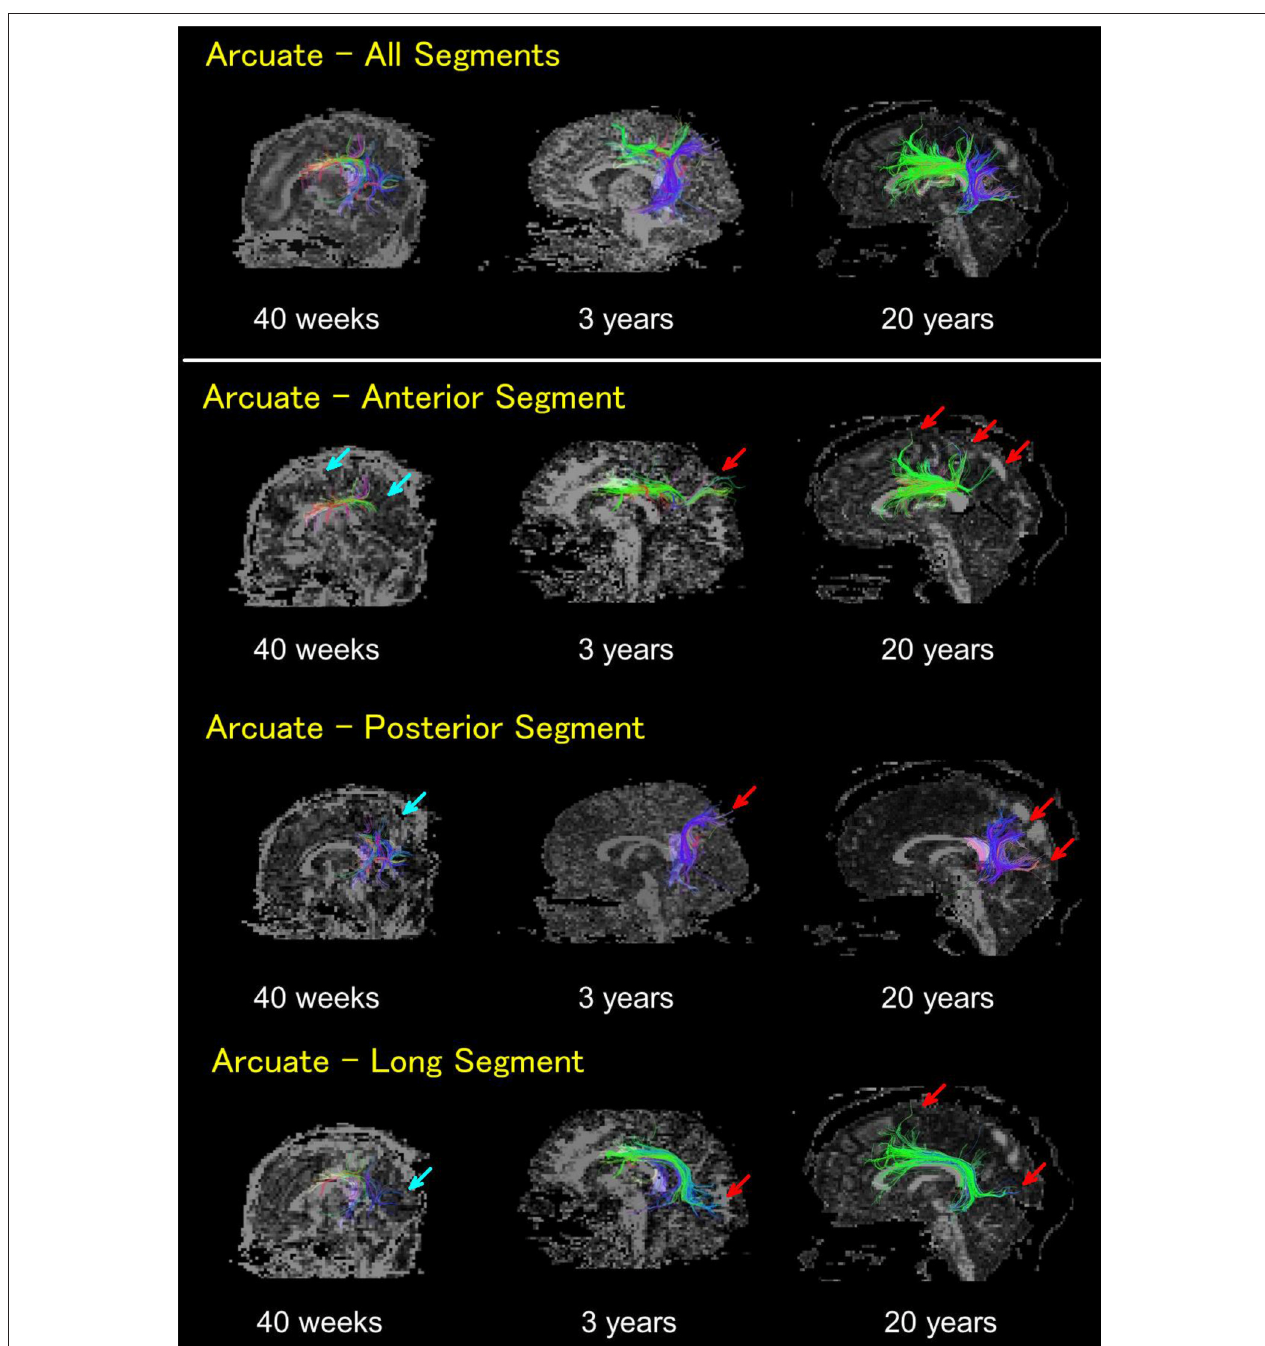
FIGURE 2 | HARDI tractography pathways on 40 gestational weeks newborn, 3 years old, and 20 years old subjects. Whole arcuate fasciculus pathways (top row), anterior segments (second row), posterior segments (third row), and long segments (bottom row). In newborns, the anterior, posterior, and long segments of the AF were all thin and sparse, with short pathways running into the cortex that were not detected in regions close to the brain surface (light blue arrows). By 3 years old, such pathways running into the cortex became obvious, with their numbers increasing until adult ages (red arrows). The color coding of fibers is based on a standard RGB code, applied to the vector between the end-points of each fiber (Red: left-right, Green: anterior-posterior, and Blue: dorsal-ventral).